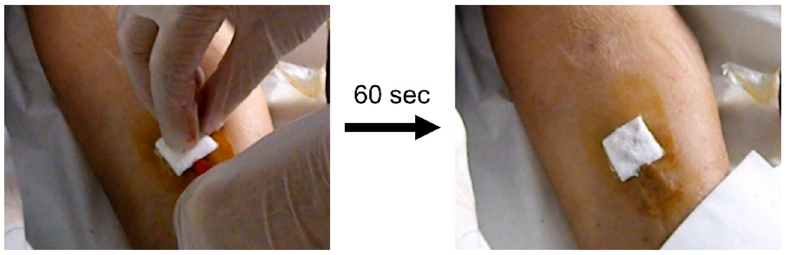
Figure 7. Hemostasis after blood dialysis with a PAA/PVP/HA sponge sheet with cotton lining. A cotton-backed PAA/PVP/HA sponge sheet is desirable for the treatment of skin- surface or fingertip injuries. The sponge can adhere to a surface wound wetted with water or an antiseptic solution. The soft sponge sheet could easily cover and stick to the fingertip without requiring a bandage or adhesive plaster. Many patients whose wounds were treated with the sponge sheet confirmed that the sponge greatly reduced pain.